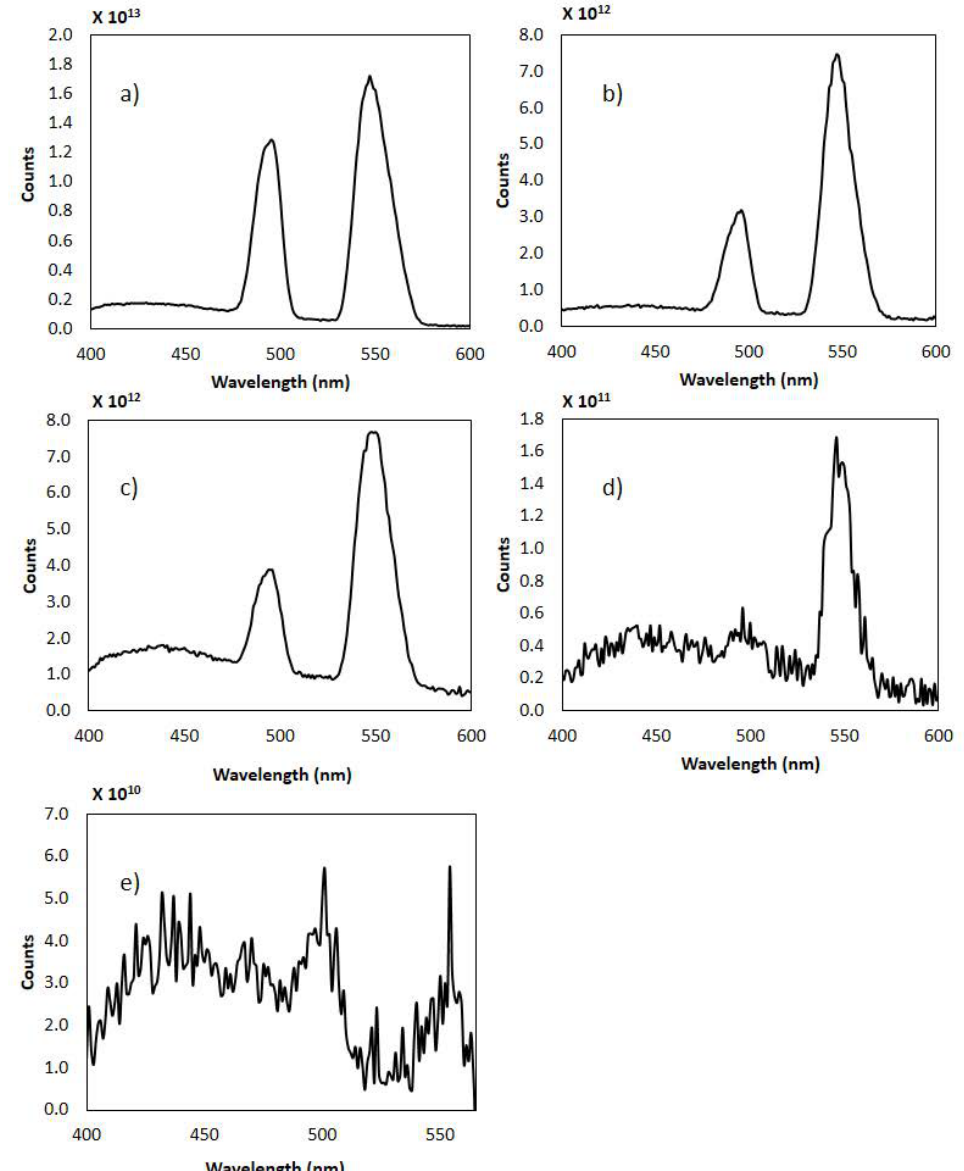
Figure 8. PL emission spectra of the samples functionalized with different coatings: ( a ) EP steel with Ag coatings (samples S3–S4); ( b ) EP steel with TiO 2 thin films (sample S5); ( c ) EP steel with double TiO 2 films plus electroless plated Ag coating (sample S7); ( d ) EP steel with TiO 2 films plus electroless plated Ag coating (sample S6); and ( e ) EP steel with TiO 2 films plus double electroless plated Ag coating (sample